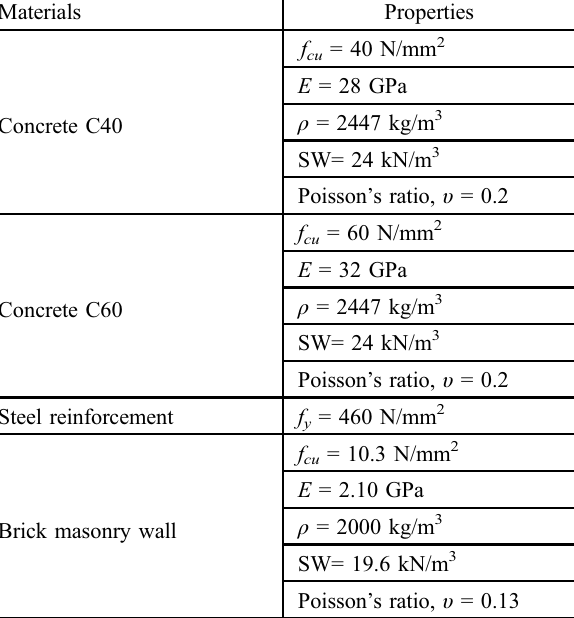
Table 2. Material properties